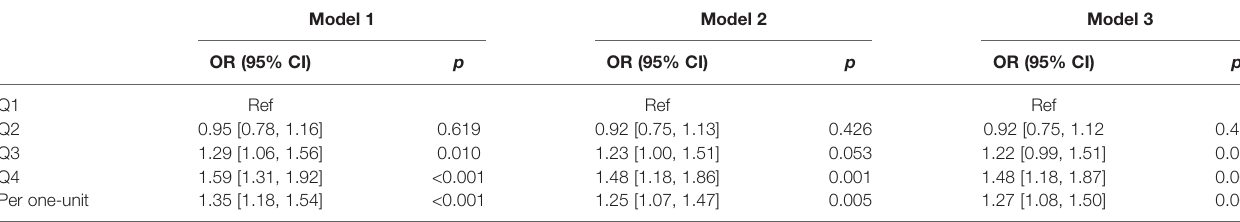
TABLE 3 | Multivariable logistic regression between C-peptide categories and subclinical myocardial injury.